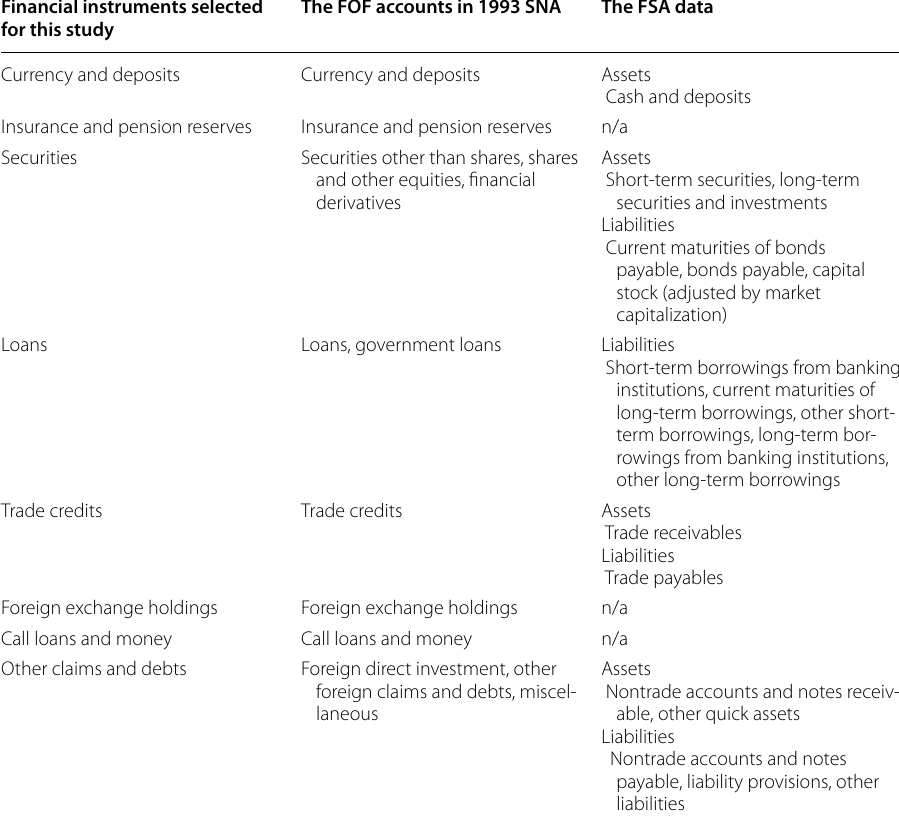
Table 2 Correspondence between FOF accounts and FSA